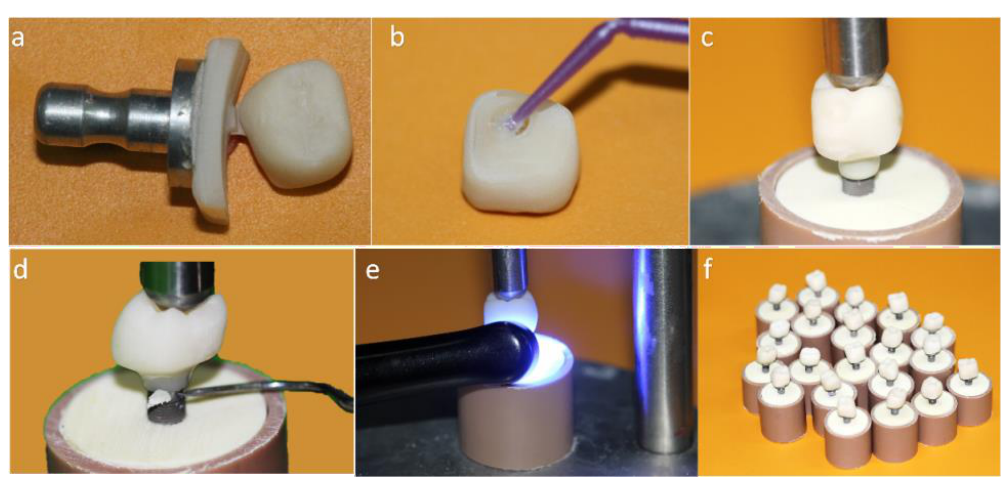
Figure 2. (a ) Monolithic crown machined in conventional block; ( b ) Silanization of the internal surface of the crown; ( c ) Luting of the crown on the titanium base (Tibase) using self-etching resin cement; ( d ) Removal of excess cement; ( e ) Light curing; ( f ) MC group crowns completed.